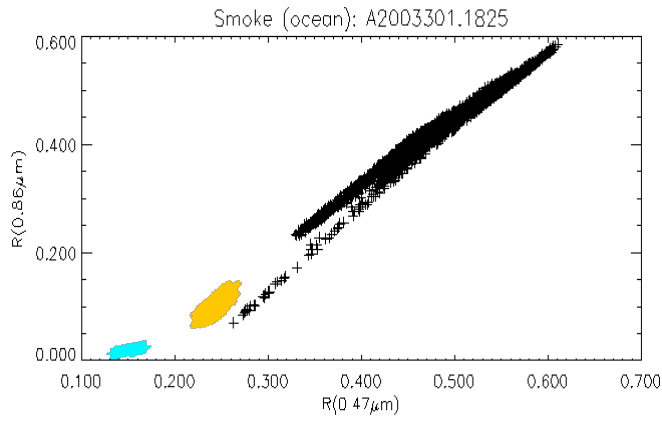
Figure 11. Scatter plots of R (yellow), and cloudy pixels (black) for the case of Figure 10.